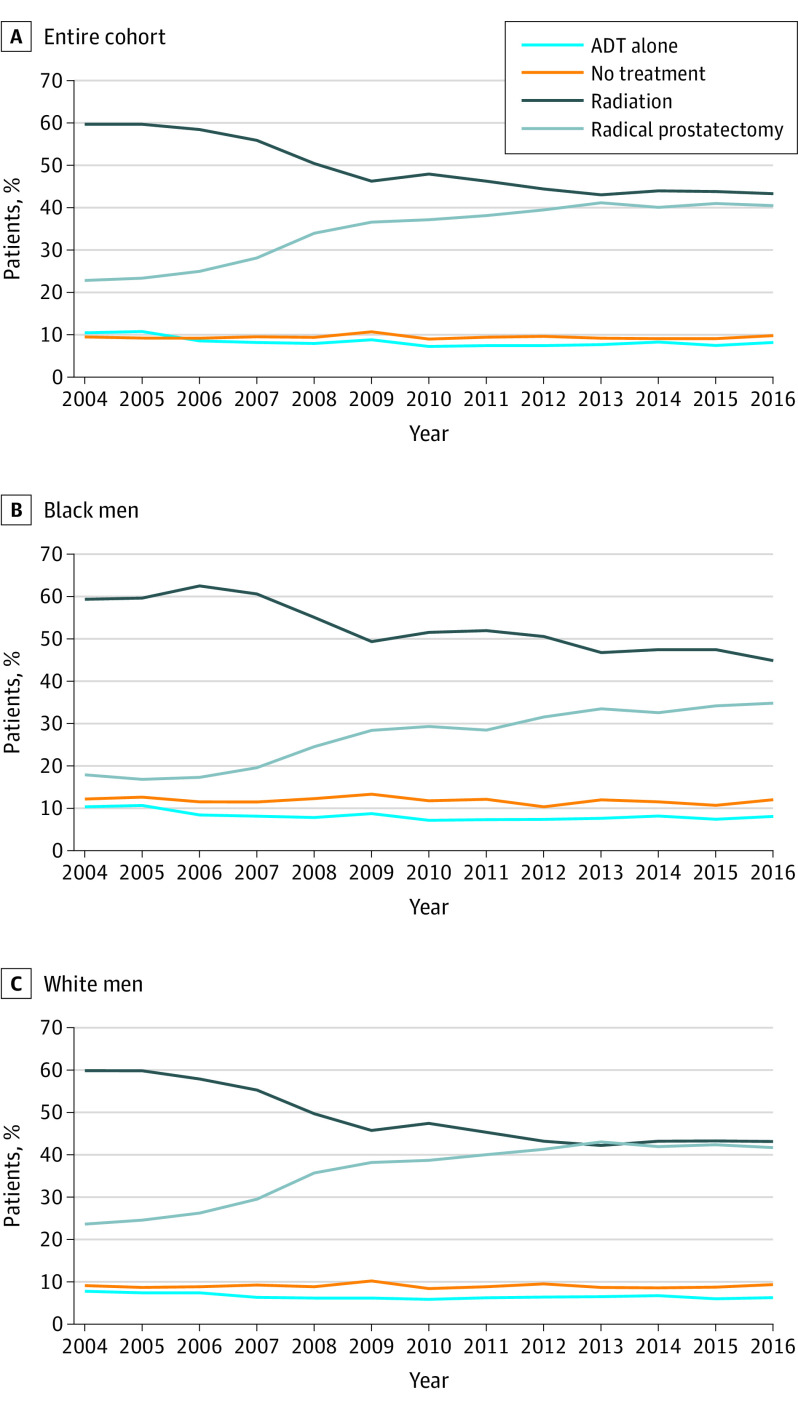
Trends in Prostate Cancer Treatment From 2004-2016ADT indicates androgen deprivation therapy.